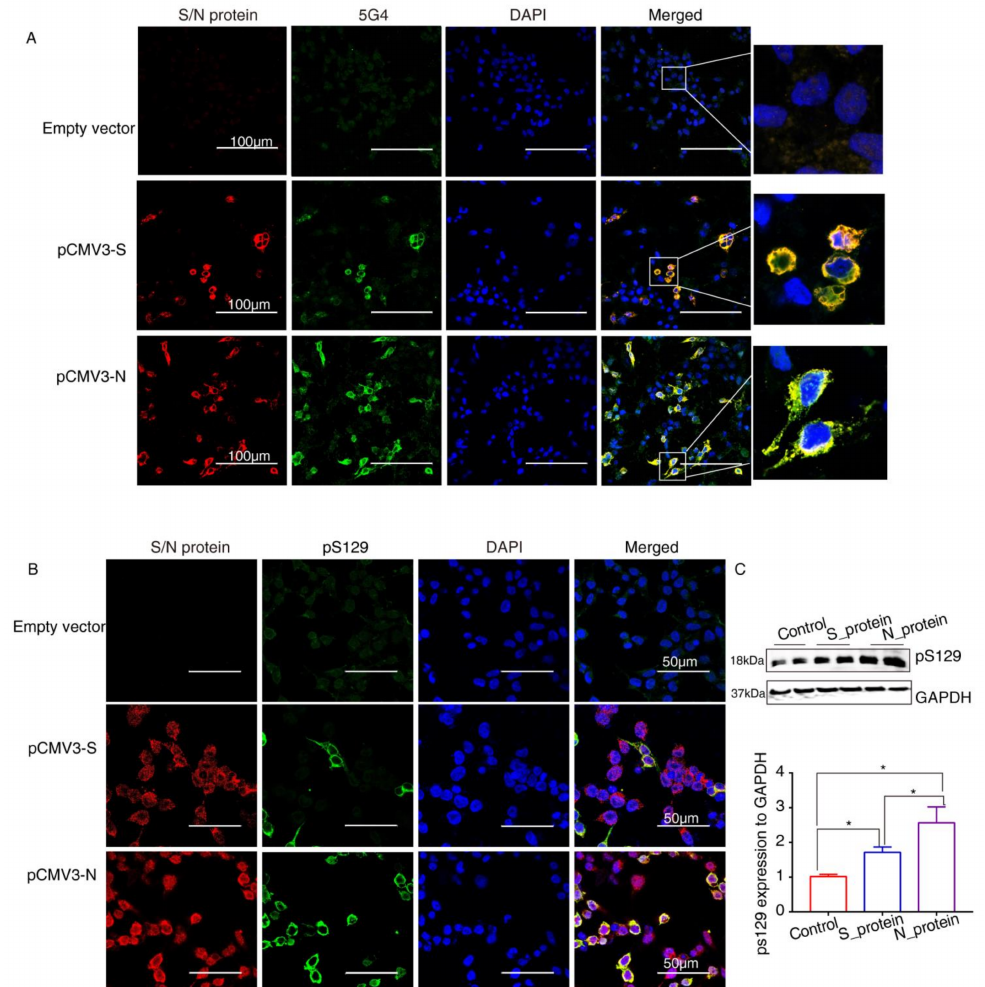
Figure 4. The SARS-CoV-2 proteins cause Lewy-like pathology in HEK293 cells overexpressing α -Syn. ( A ) Seventy-two hours after HEK293 cells overexpressing α -Syn had been transfected with pCMV3-S or pCMV3-N plasmids, they were fixed and stained with anti- α -Syn aggregate (5G4). Expression of aggregated α -Syn was observed using fluorescence confocal microscopy. ( B ) Seventy-two hours after HEK293 cells overexpressing α -Syn had been transfected with pCMV3-S or pCMV3-N plasmids, the cells were fixed and stained with anti-pS129- α -Syn. The results were observed under fluorescence confocal microscopy. ( C ) The total protein from the HKE293 cells was extracted and detected by anti-pS129- α -Syn. The expression levels were assessed by ImageJ. * p <